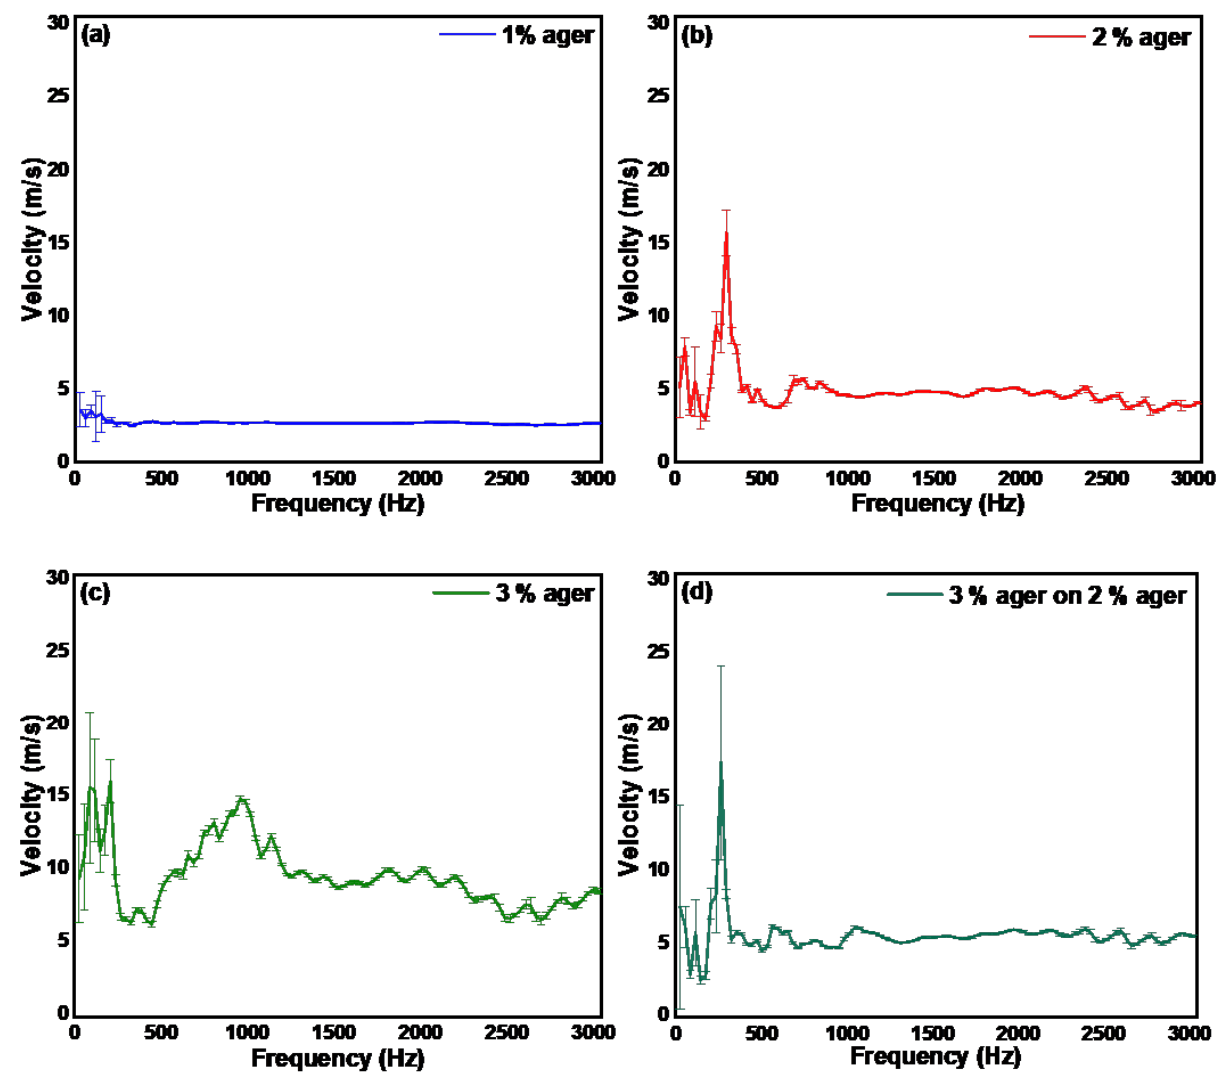
Figure 2. Surface acoustic wave velocity measured using pulsed excitation method in ( a ) mono- layer 1%, ( b ) monolayer 2% ( c ) monolayer 3%, and ( d ) dual layer 3% on 2% ager phantom.